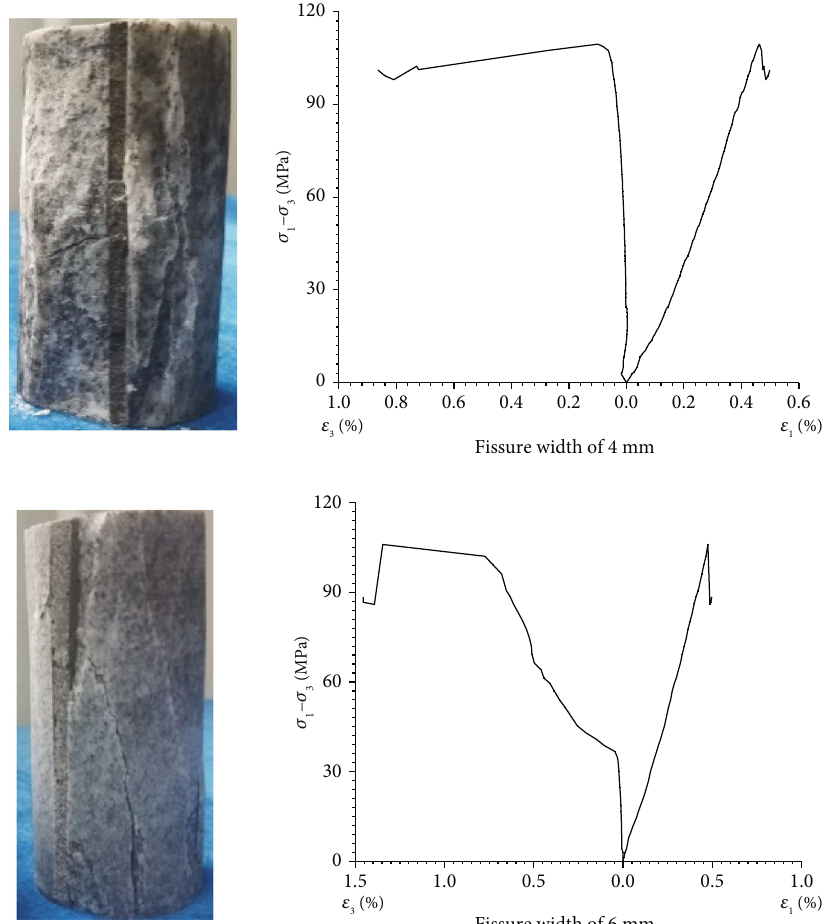
Figure 9: Stress-strain curve and typical failure mode of specimens with di ff erent fi ssure